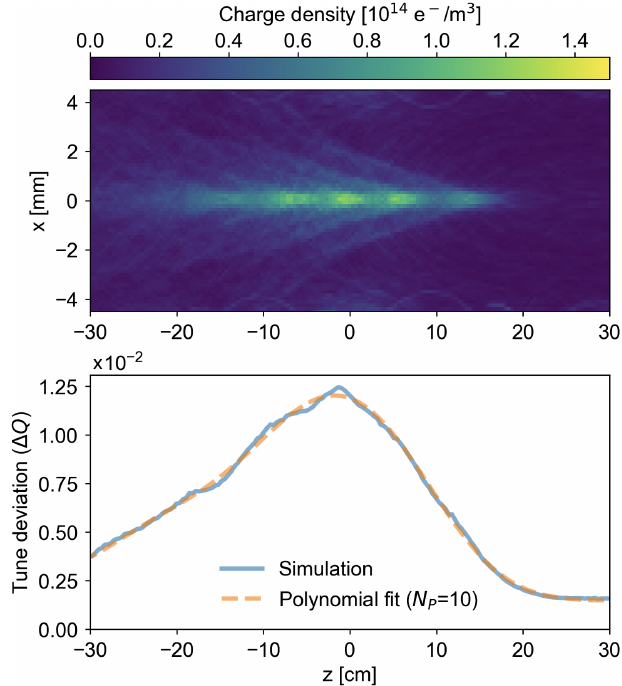
FIG. 2. Top: evolution of the electron density in the plane y ¼ 0 during the passage of a bunch. Bottom: corresponding effect on the particle betatron